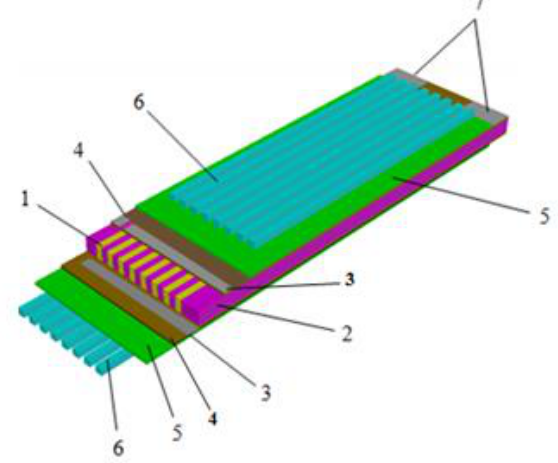
Fig. 1. The structure of the magnetopiezofiber in the section: 1 - piezoelectric fibers; 2 - epoxy; 3 - interdigital electrode; 4 - polyimide films; 5 - epoxy; 6 - magnetostrictive